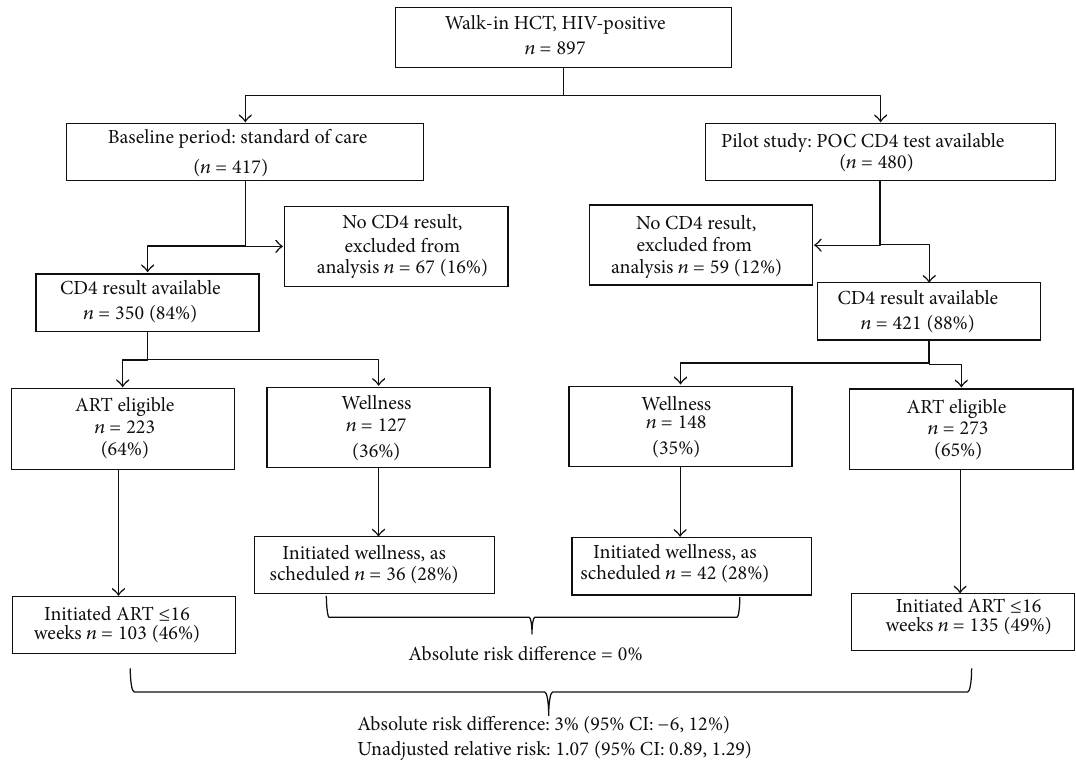
Figure 1: Summary of study groups, sample sizes, and